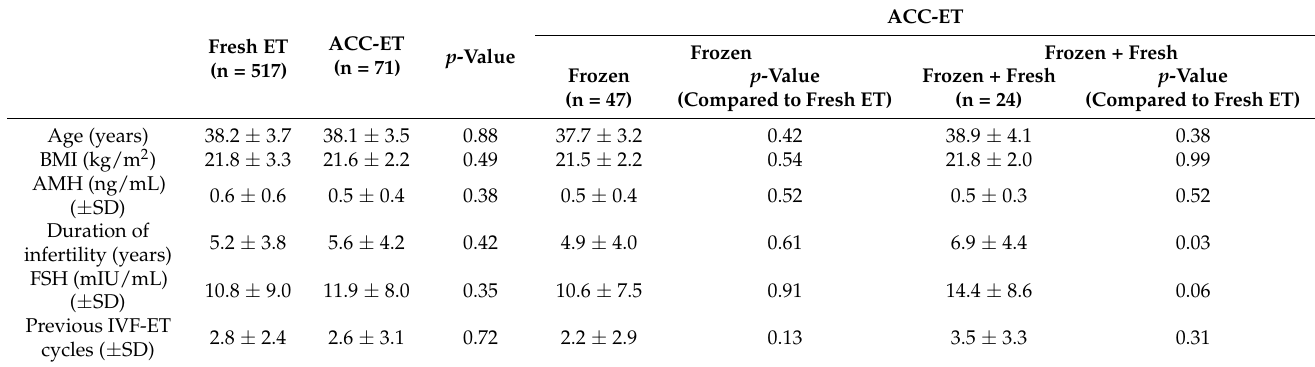
Table 1. Basal characteristics of fresh ET and ACC-ET group.